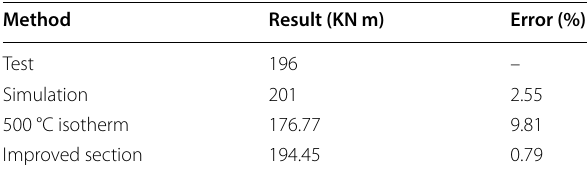
residual concrete maintains its initial values of strength and elastic modulus. On the basic of the above assump- tions, after obtaining the 500 °C isotherm, then deter- mine a new width b fi and a new effective height d fi of the section by excluding the concrete outside the 500 °C isotherm. The rounded corners of isotherms can be